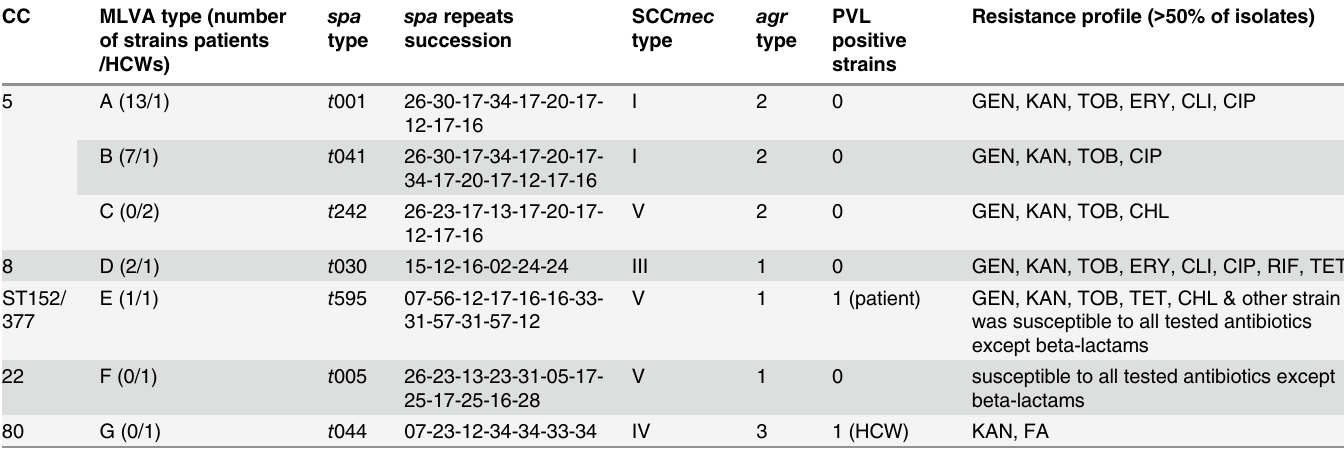
Table 4. Characteristics of 31 methicillin-resistant Staphylococcus aureus (MRSA) strains isolated from nasal and throat swab specimens ob- tained from patients and healthcare workers (HCWs) at the Clinical Centre of Serbia,